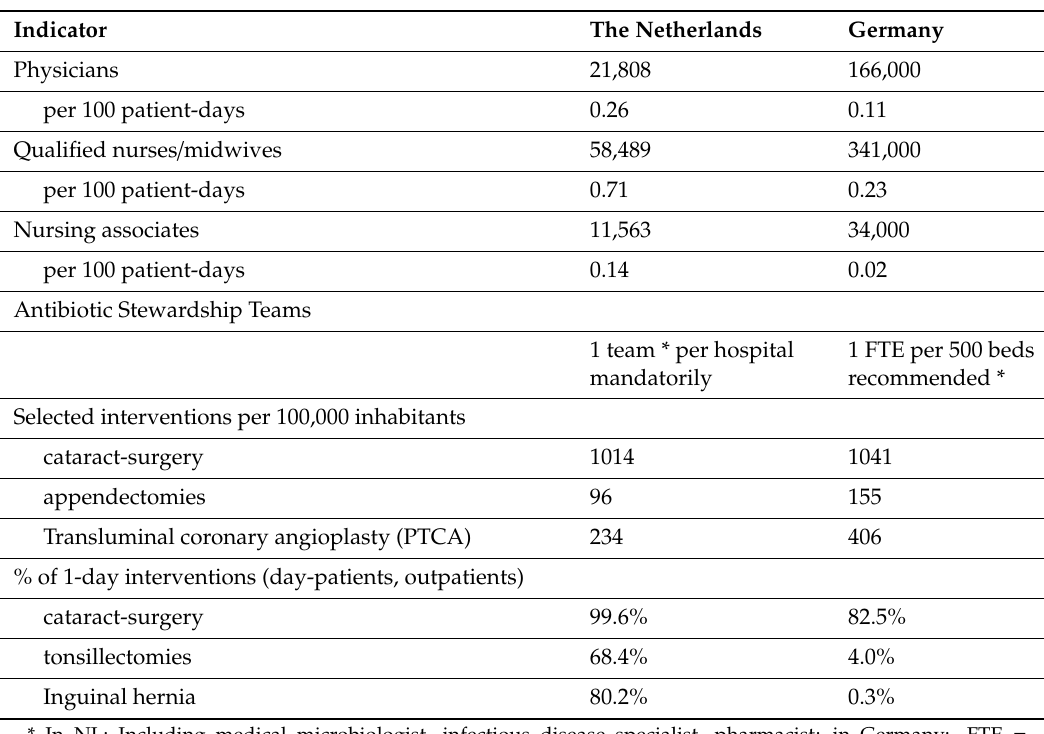
Table 4. Structures of the healthcare systems in The Netherlands and Germany